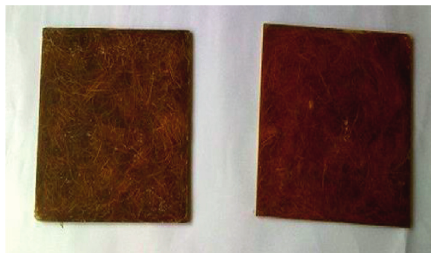
Figure 1: Photographic image of fiber reinforced sheet.